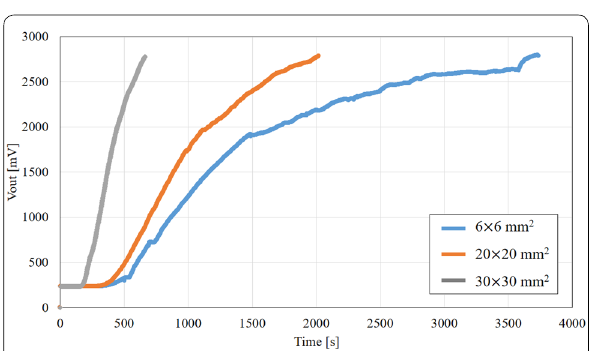
Fig. 4 Real‑time measurement results of negative ion detection in the air depending on the size of the extended gate electrode of the nanoFET